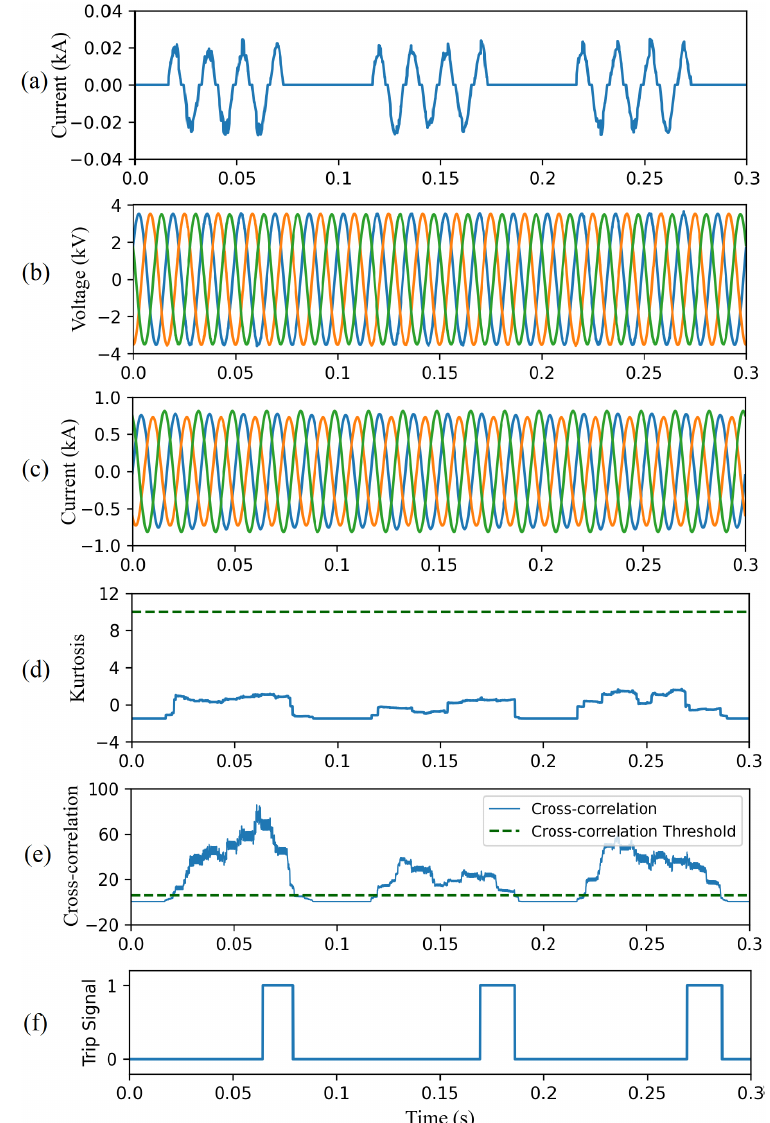
Figure 16. CAE-HIFD performance under intermittent HIF condition: ( a ) fault current, ( b ) three- phase input voltages, ( c ) three-phase input currents, ( d ) kurtosis of the input, ( e ) cross-correlation, and ( f ) trip